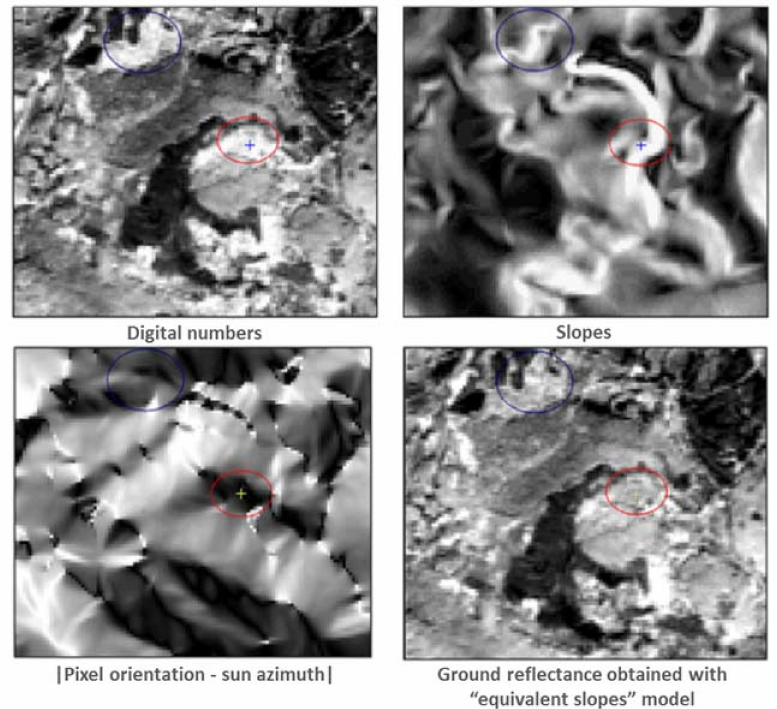
Figure 22. Example of topographic effects reduction by the equivalent slopes model applied to an NIR band of the SPOT 1 image acquired on 5 September 1988 in the Tarn region,